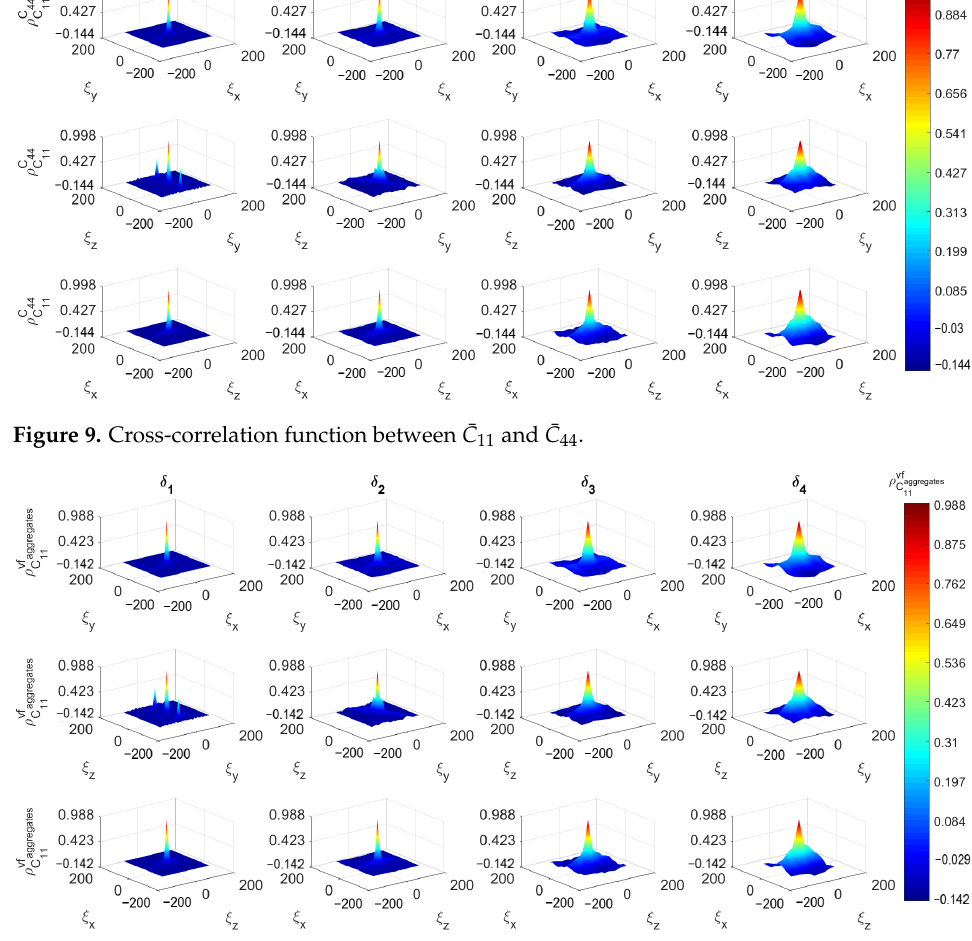
Figure 10. Cross-correlation function between ¯ C 11 and vf of